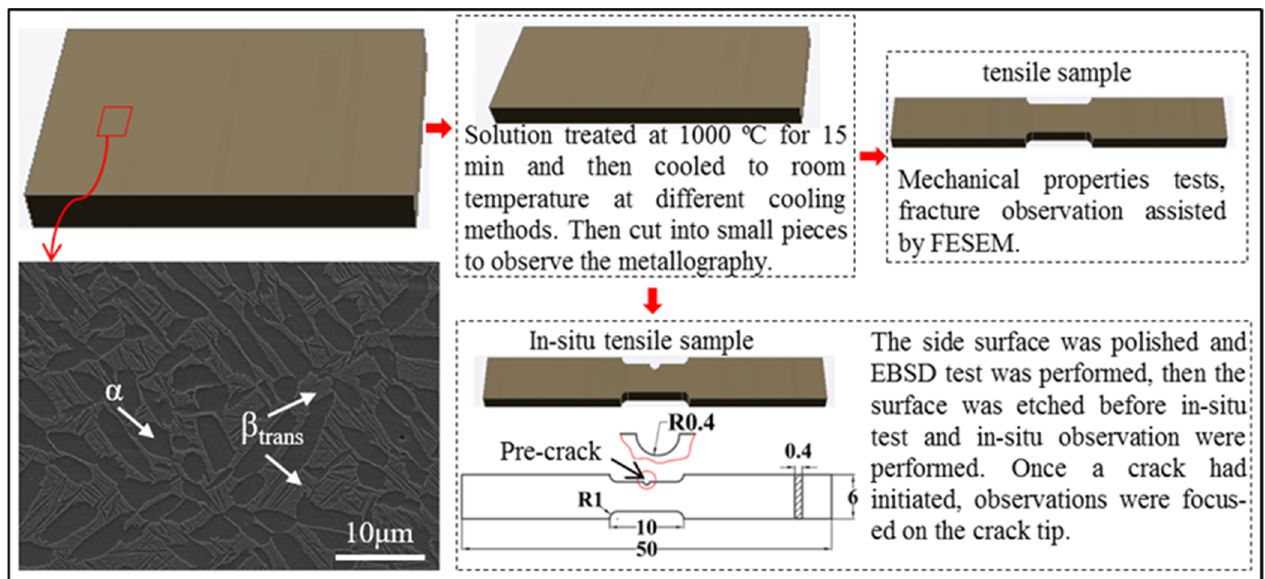
Figure 1. Schematic preparation process of the tensile specimen and original microstructure of TC21 alloy (lower left) (units of tensile sample: mm).